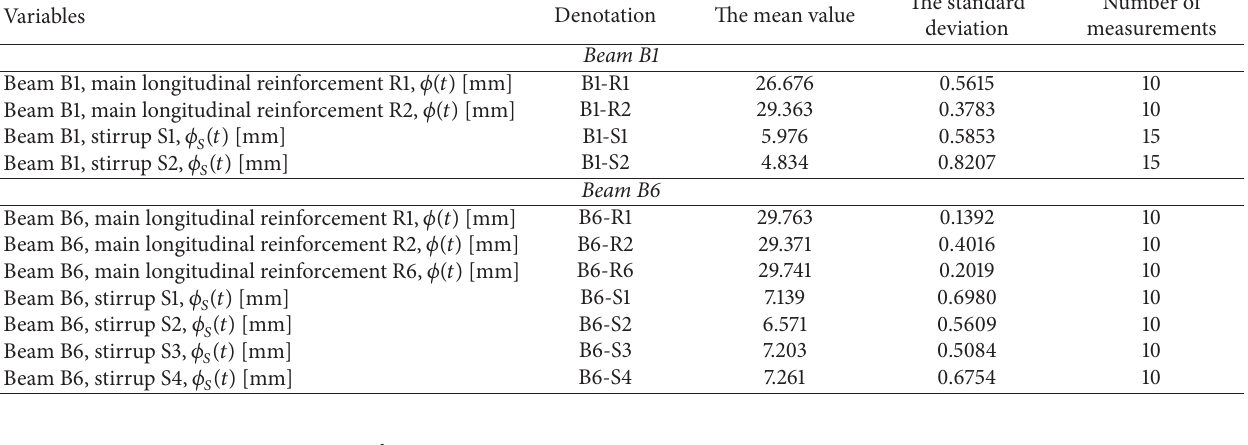
Table 2: Measured values of reinforcement diameters.